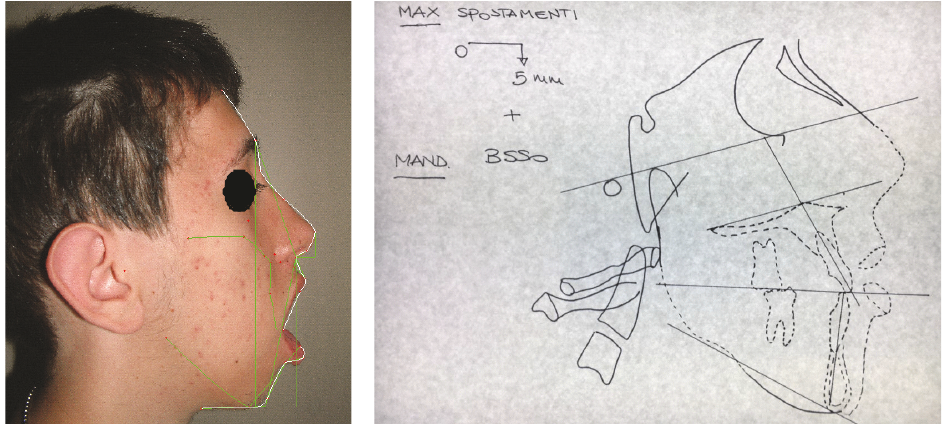
Figure 5: Arnett-Bergman soft tissues analysis and VTO before